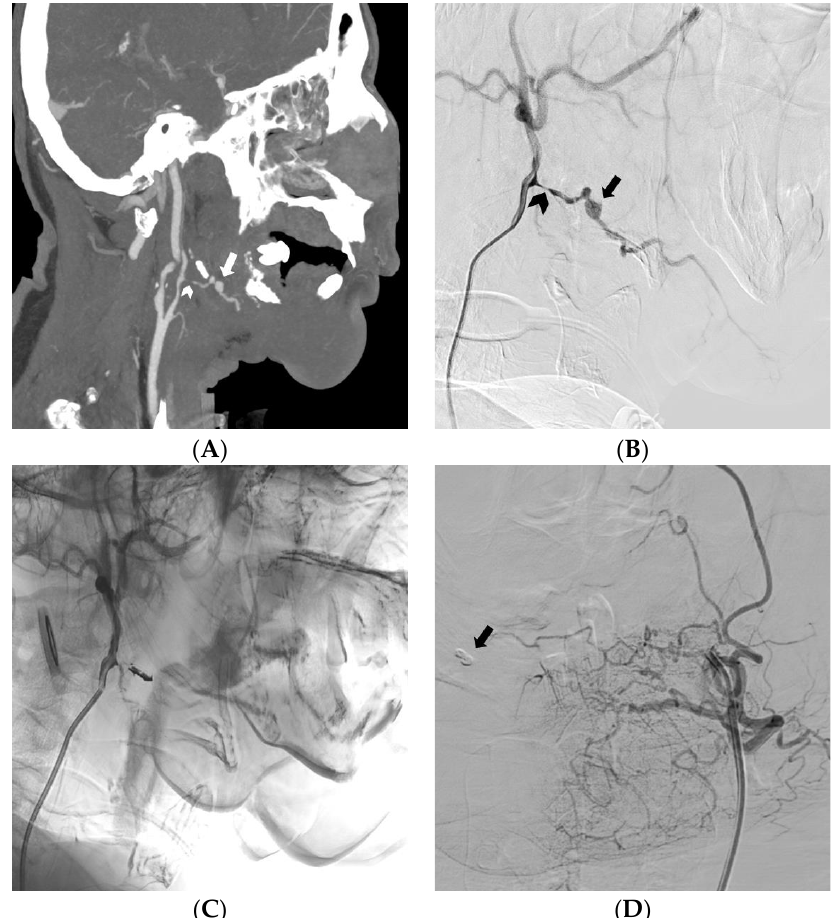
Figure 6. Locally advanced squamous cell carcinoma of the tongue. CT angiography with maximum intensity projection reformatting in the sagittal plane ( A ) and digital subtraction angiography of the external carotid artery ( B ). Massive oral bleeding from a pseudoaneurysm (arrow) of a heavily eroded (arrowhead) right lingual artery ( A , B ). Angiogram demonstrating effective embolization of the lingual artery with EVOH copolymer ( C ). Contralateral digital subtraction angiography excluding retrograde bleeding; the onyx cast can be noted (arrow) ( D ).